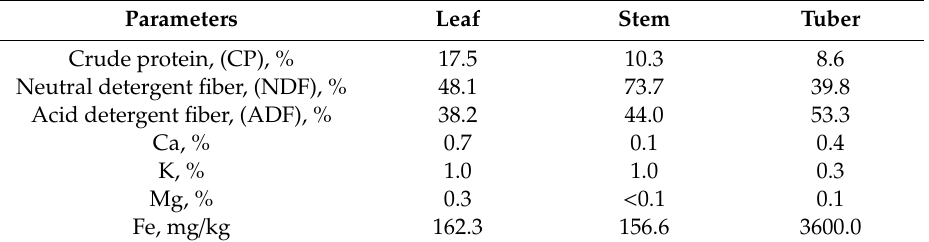
Table 6. Nutritive values of kudzu ( P. montana ) plant parts